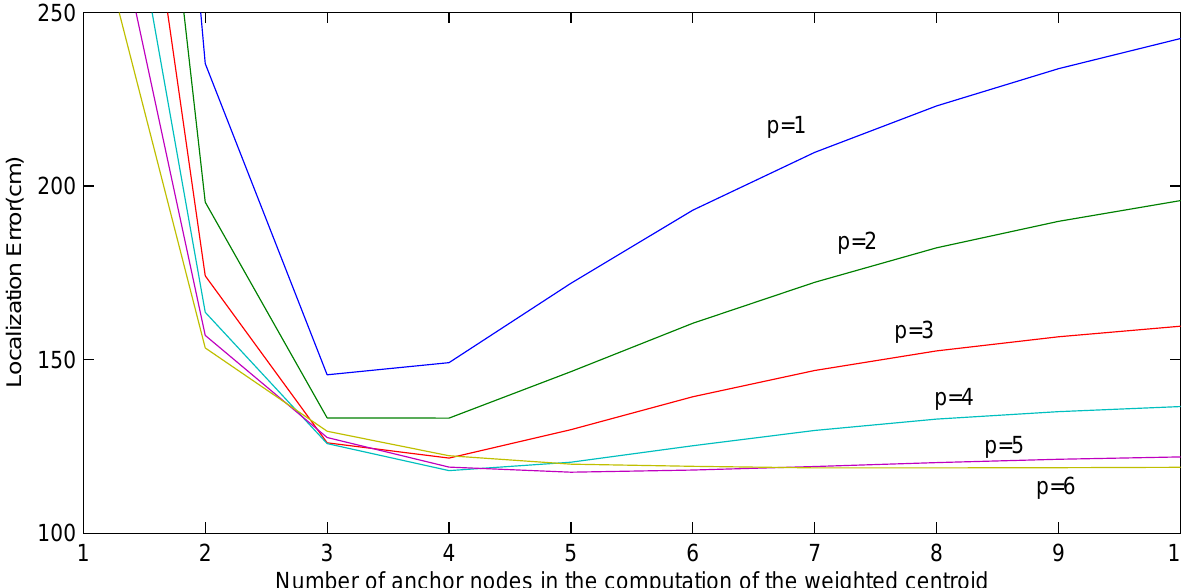
Figure 5. Evaluation of the effect of p and the number of anchor nodes in the WCL